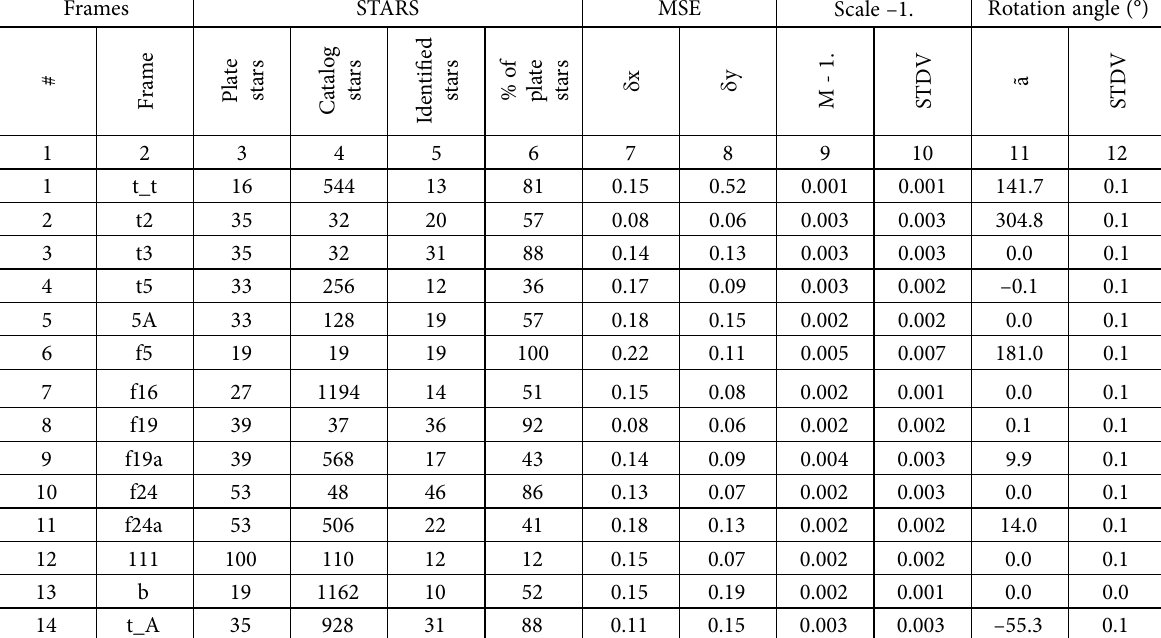
Table 2. Test of similarity of two converging vector’s beams Frames STARS MSE Scale